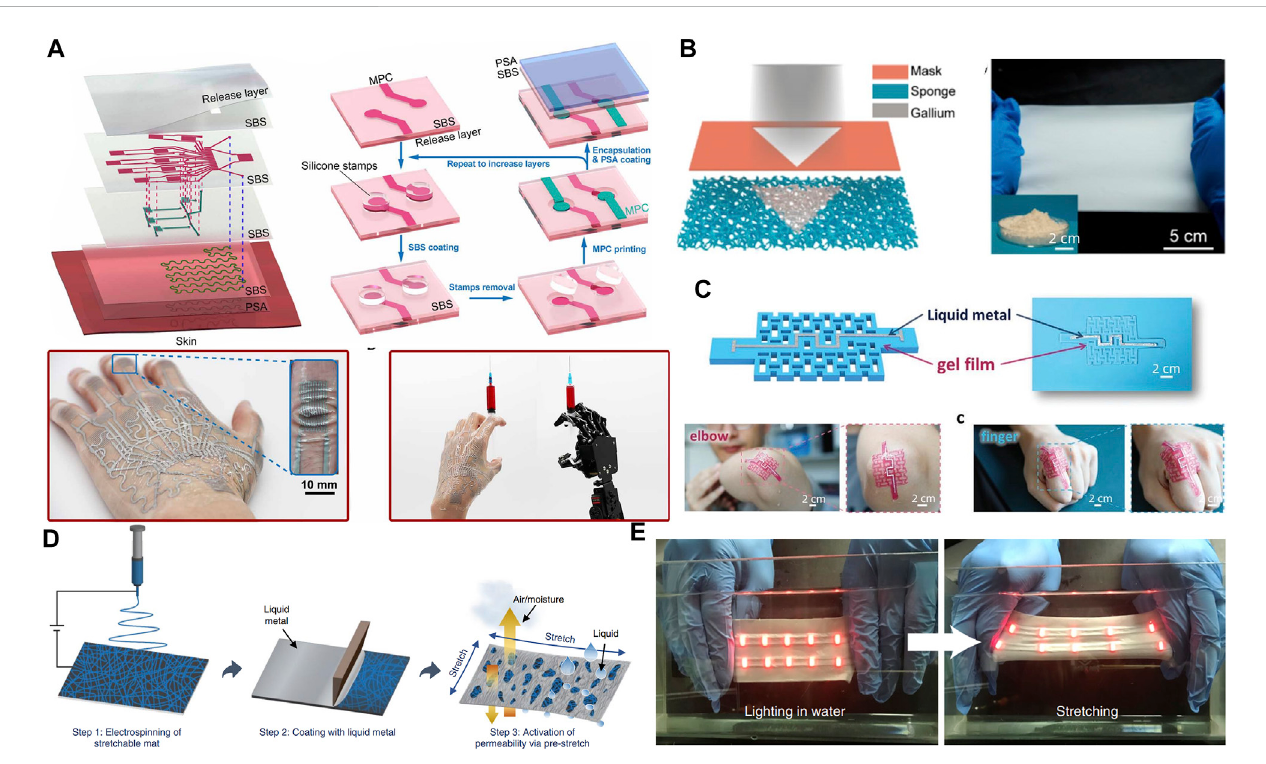
Multilayer and breathable conformal electronics. (A) Exploded schematics of the METT containing three circuit layers. (Tang et al., 2021). Copyright@ 2021, AAAS (B) Schematic illustration of the LM micromesh by physical deposition of LM on the metalized sponge with copper. (Li et al., 2022c). Copyright@ 2022, ACS (C) Schematic for the design and the photo of soft electronics. (Yu et al., 2021) Copyright@2021, Wiley (D) Schematic illustration of a typical fabrication process of an LMFM (Ma et al., 2021). Copyright@2021, Springer nature (E) Images of the encapsulated stretchable mat printed with EGaIn interconnects and mounted LEDs underwater. (Ma et al., 2021). Copyright@2021, Springer